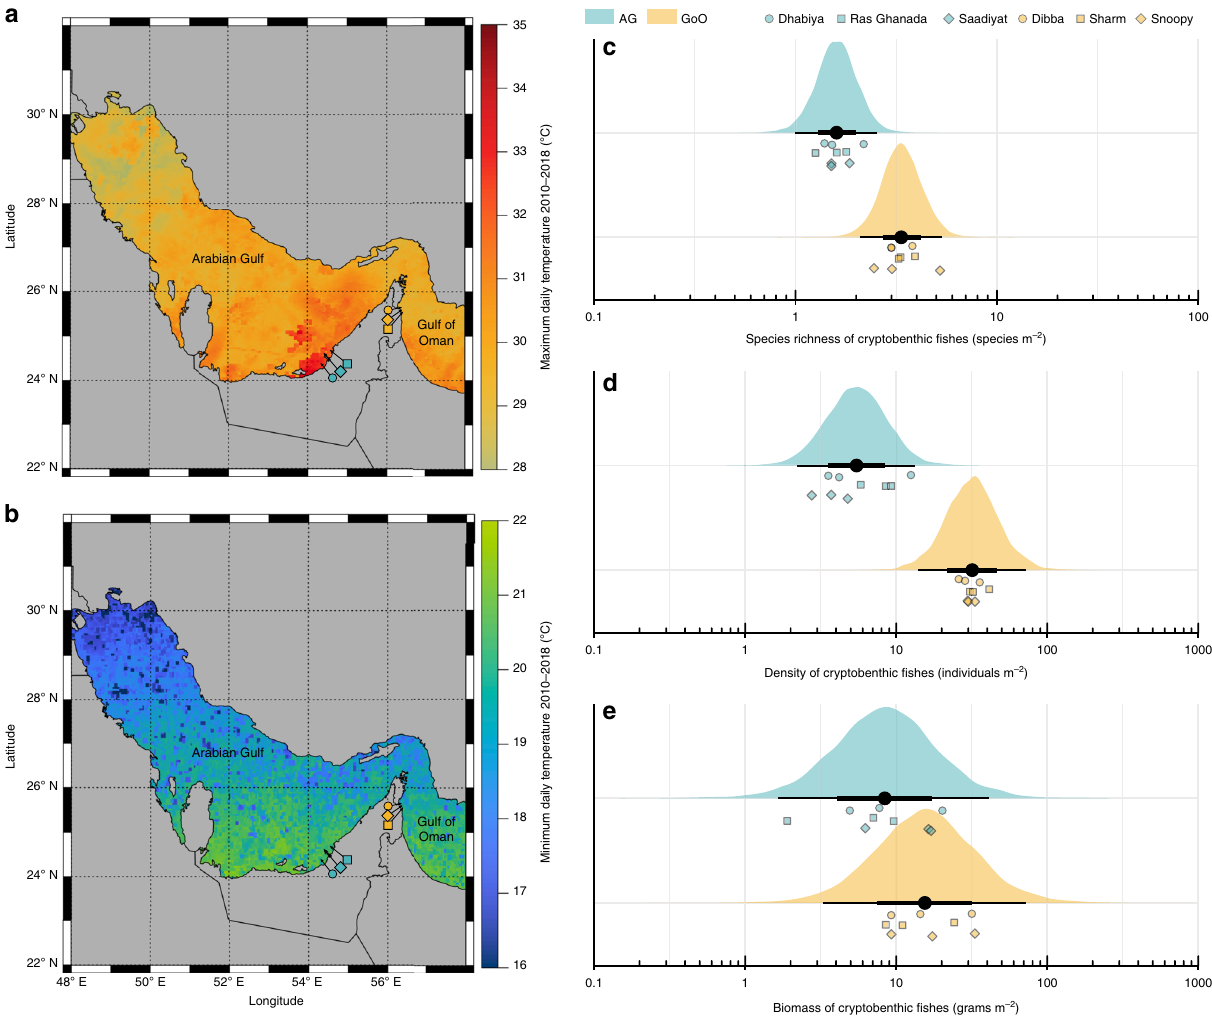
Fig. 1 Map of the study system and community structure of cryptobenthic reef fi sh communities in the Arabian Gulf (AG) and Gulf of Oman (GoO). a , b Maximum and minimum daily temperature estimates between 2010 and 2018, with the study sites indicated. c − e Species richness, abundance, and biomass of cryptobenthic fi sh communities. Density curves and black caterpillar plots (50 and 95% credible intervals) represent posterior predictions, while circles, squares, and diamonds represent raw values from the respective sites in each location, jittered on the y